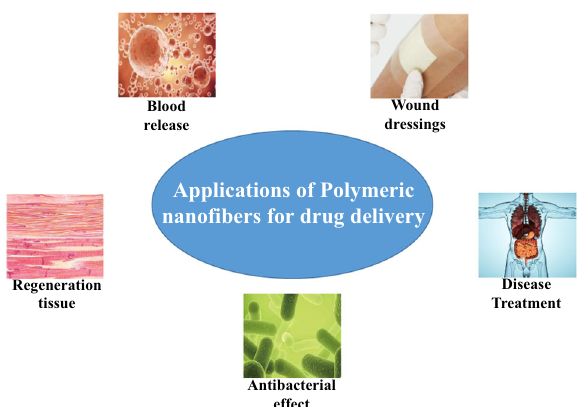
Fig. 7 Summary diagram of polymeric nano fi bers for drug delivery